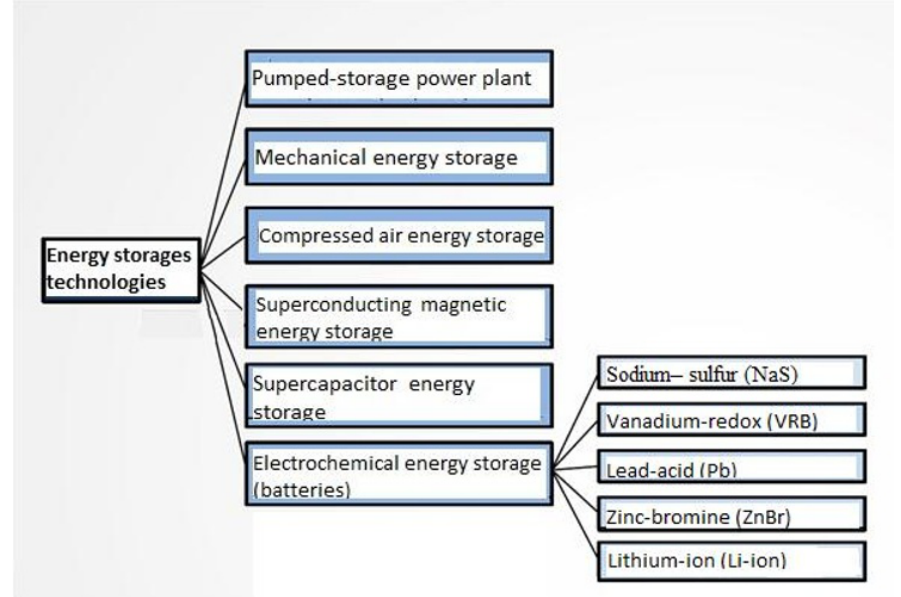
Fig. 1. Classification of energy storage facilities